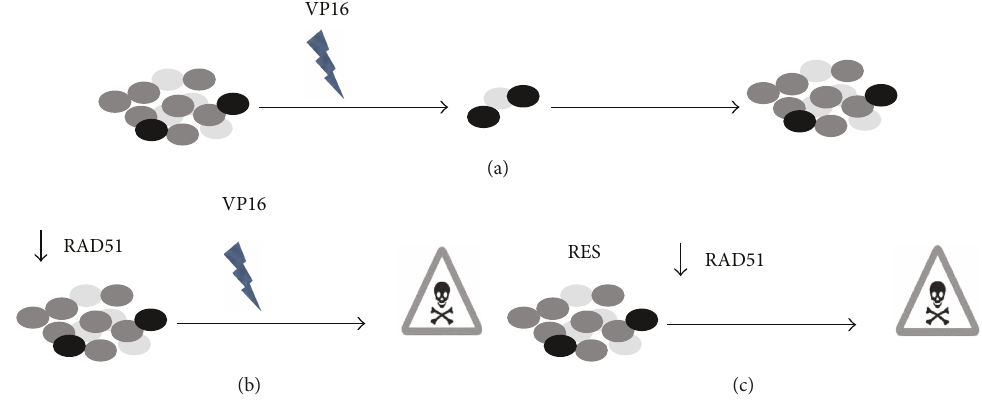
Figure 7: Proposed model explaining the mechanism of chemosensitization of cancer stem cells (CSC) by RESveratrol (RES) involves inhibition of RAD51. We propose that VP16-resistant CSC induced cell death (a) (as found in this work for HeLa SPhere cultures). However, when CSC are treated with siRAD51, as shown in (b), they become sensitive to VP16. Interestingly, when CSC are treated with RES, as indicated in (c), this polyphenol reduces RAD51 protein expression and induces cell death. This e ff ect is increased in combination with VP16.